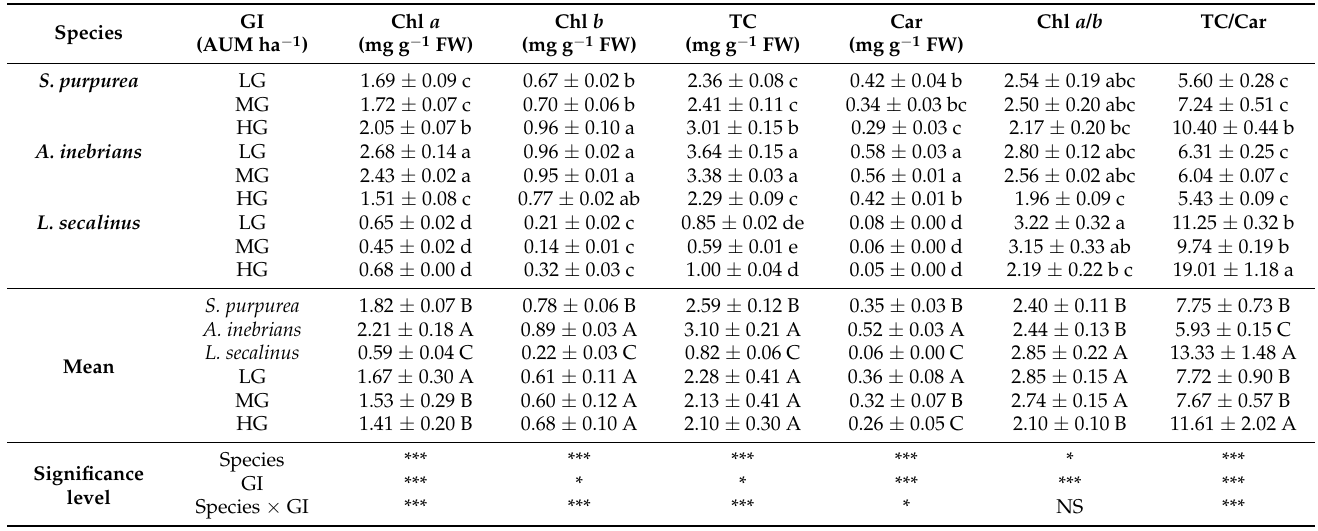
Note: The data are presented as mean ± standard error (SE) of three independent experiments. * p ≤ 0.05; ** p ≤ 0.01; *** p ≤ 0.001; NS, no significance. Abbreviations: S. purpurea , Stipa purpurea ; A. inebrians , Achnatherum inebrians ; L. secalinus , Leymus secalinus. GI, Grazing intensity; LG, light grazing; MG, medium grazing; HG, heavy grazing; Chl a , chlorophyll a; Chl b , chlorophyll b; TC, total chlorophyll; Car, total carotenoid; Chl a / b , chl a /chl b ratio; TC/Car, TC/Car ratio. Different lowercase letters mean significant difference ( p ≤ 0.05) between same species under different grazing intensities. Different uppercase letters mean significant difference ( p ≤ 0.05) between different species or different grazing